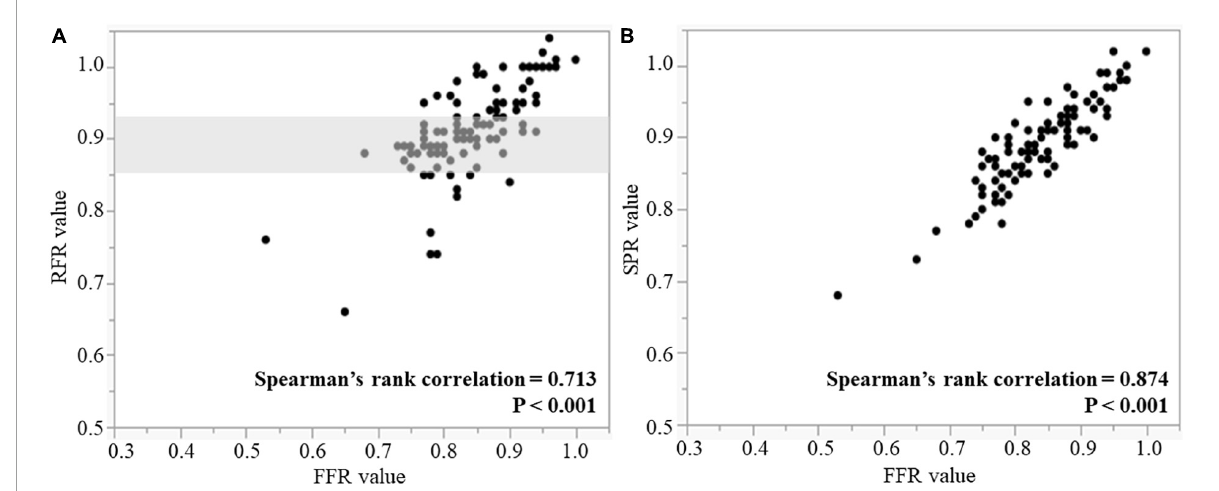
FIGURE2 Correlations between RFR and FFR (A) , and SPR and FFR (B) . Gray shaded area is the RFR gray zone of 0.86–0.93. RFR, resting full-cycle ratio; SPR, saline-induced Pd/Pa ratio; FFR, fractional flow reserve.